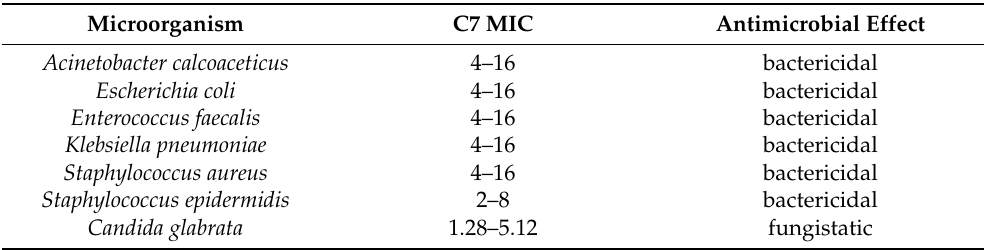
Table 5. Summary of antibacterial and antifungal properties of C7 ( n = 2, with 8 replicates per condition, in accordance with the standardized protocols).